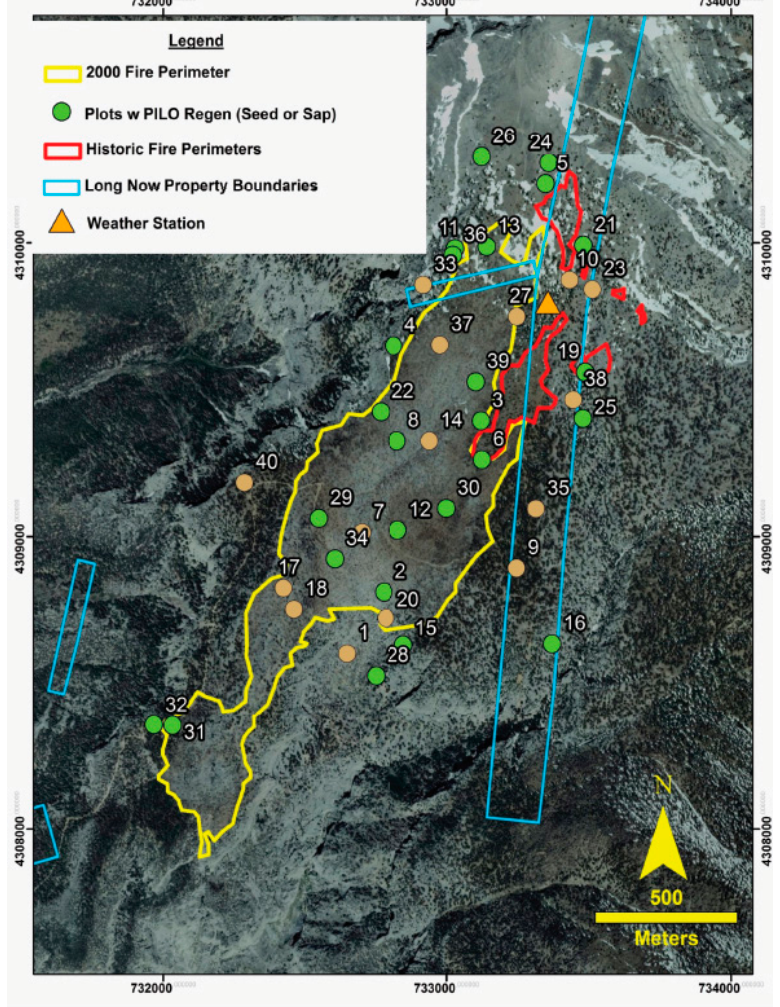
Figure 1. Map of the study area obtained from Google Earth TM imagery overlaid with the boundary of the year 2000 Phillips Ranch Fire (yellow line) and with the perimeter of older fires (red lines). Geographical coordinates are provided by the Universal Transverse Mercator (UTM) grid (zone 11 S), with tick marks and labels outside the image. The 40 randomly located plots are shown by solid green circles when they included Pinus longaeva (PILO) regeneration, and by solid light orange circles otherwise.